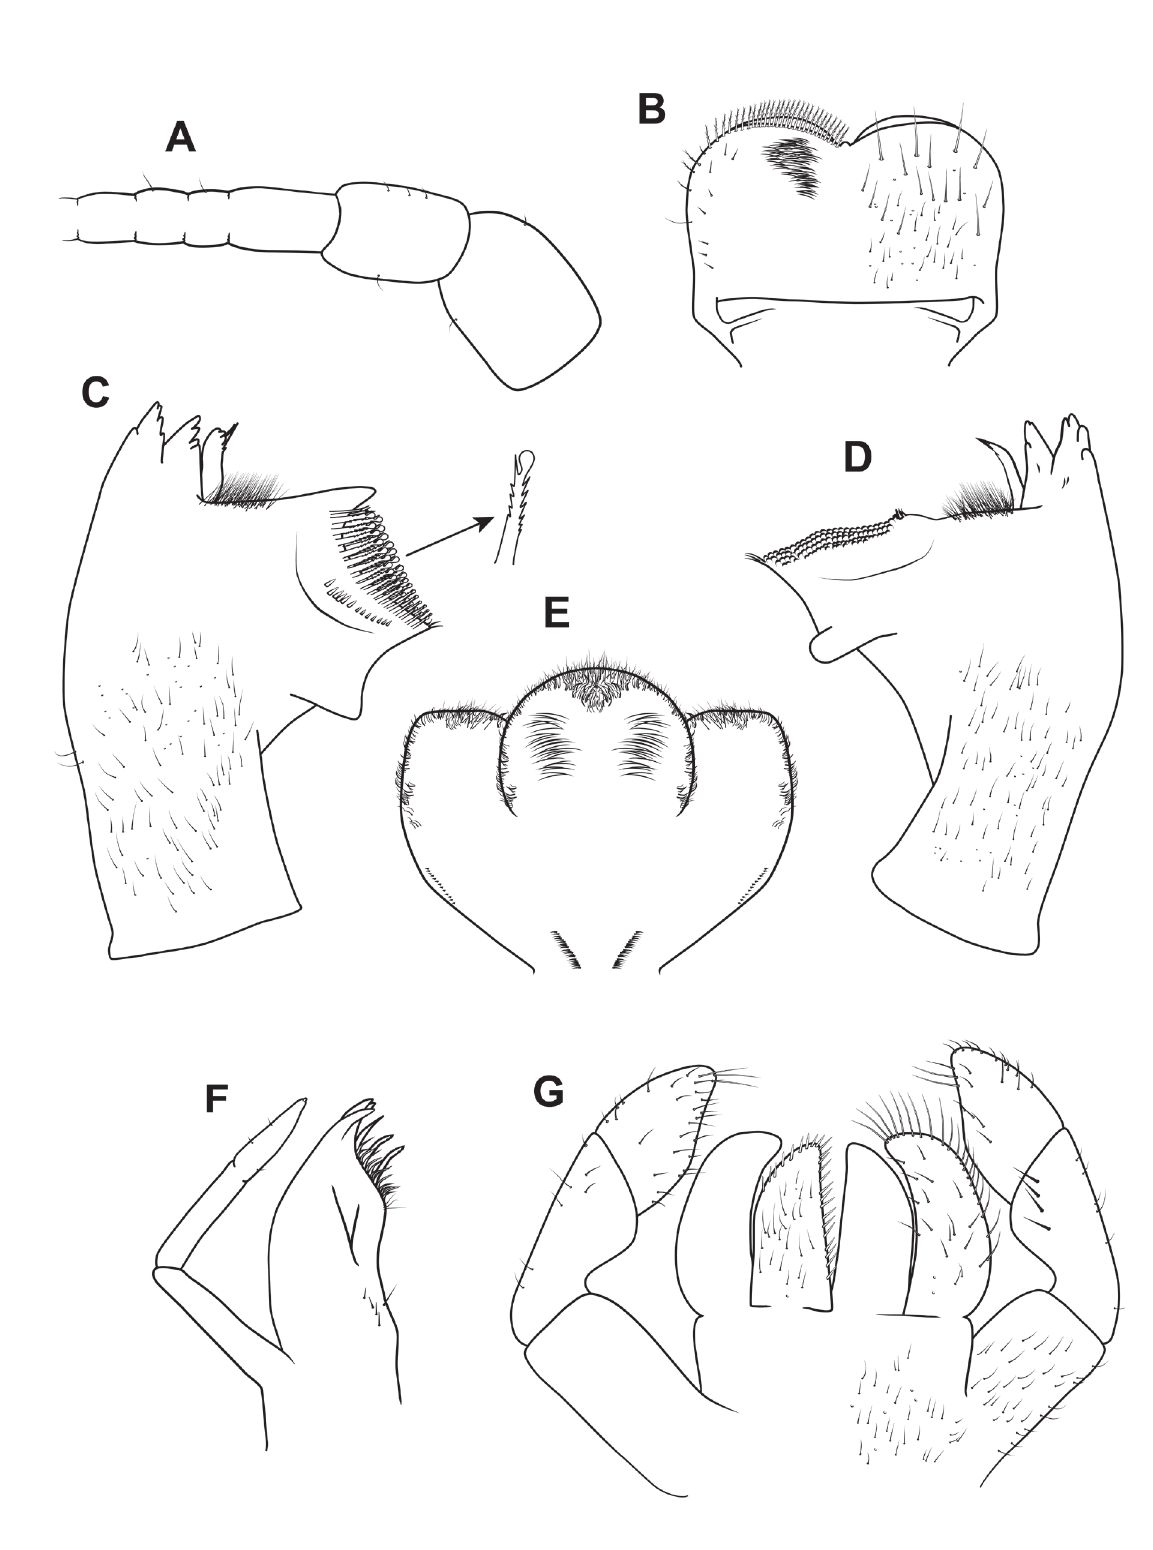
Fig. 5. Cloeon perkinsi , nymph. A . Antennal scape, pedicel and first flagellomeres. B . Labrum (left, ventral; right, dorsal). C . Left mandible (typical molar tooth enlarged). D . Right mandible. E . Hypopharynx. F . Maxilla. G . Labium (left, ventral; right, dorsal). All mouthparts